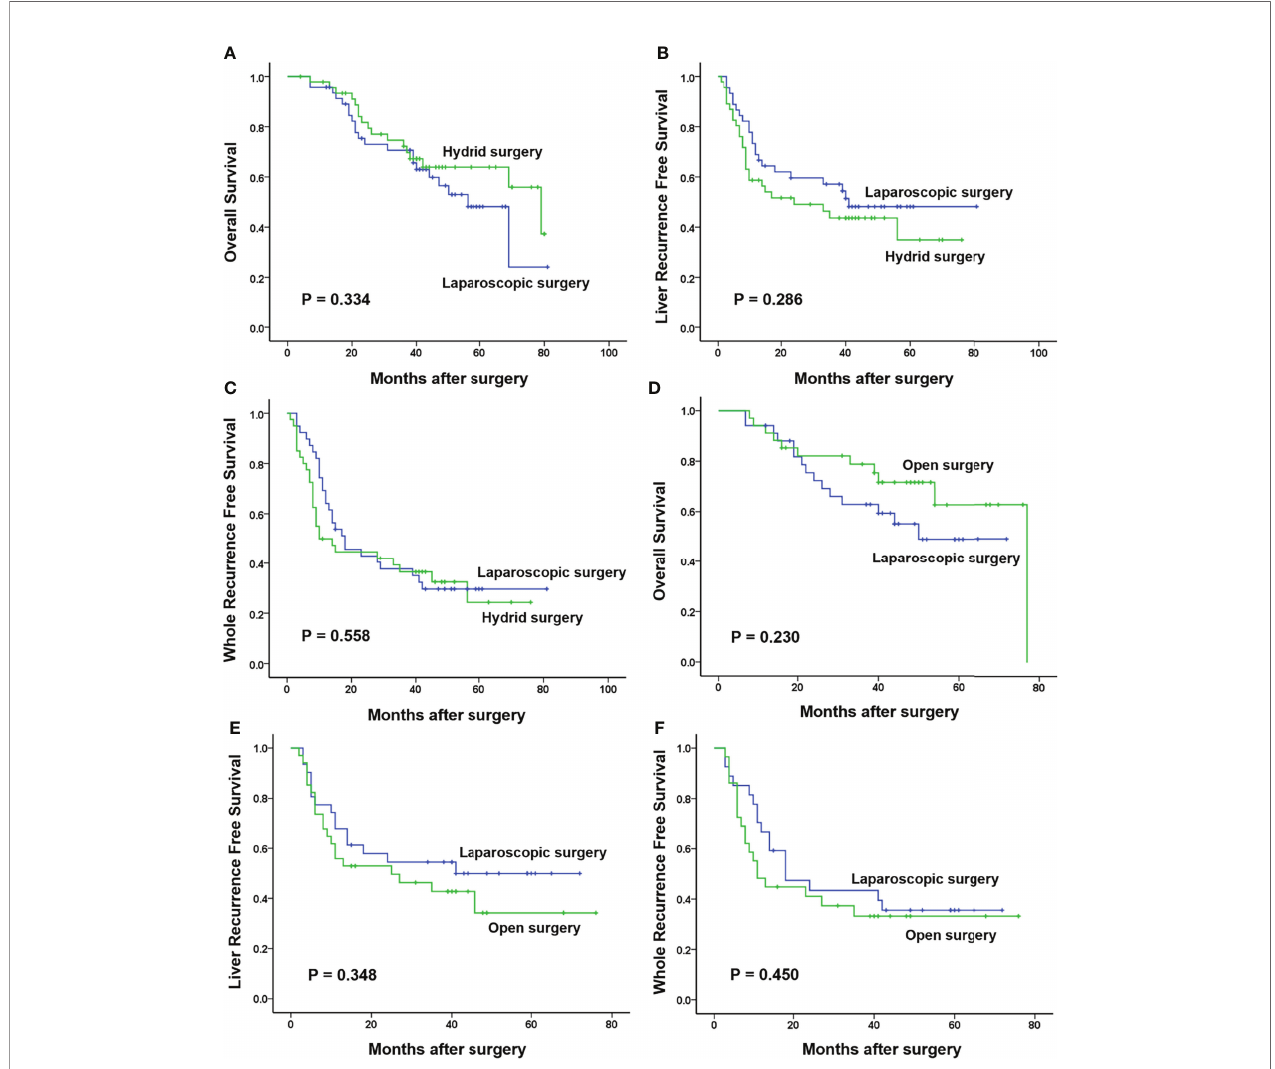
FIGURE 2 | Long-term survival in three groups after propensity score matching. (A – C) One-, 3-, and 5-year overall survival (OS), liver recurrence-free survival (RFS), and whole RFS in the laparoscopic surgery group were 96%, 71%, and 48%; 73%, 57%, and 47%; and 69%, 38%, and 29%, respectively, which were similar with those in the hybrid surgery group (98%, 75%, and 63%; 58%, 43%, and 37%; and 49%, 36%, and 27%, respectively; p = 0.334, p = 0.286, and p = 0.558). (D – F) There were also no signi fi cant differences in 1-, 3-, and 5-year OS, liver RFS, and whole RFS between the laparoscopic surgery group (94%, 63%, and 48%; 68%, 54%, and 50%; and 70%, 44%, and 35%, respectively) and the open surgery group (94%, 79%, and 63%; 56%, 43%, and 38%; and 48%, 33%, and 33%, respectively; p = 0.230, p = 0.348, and p =